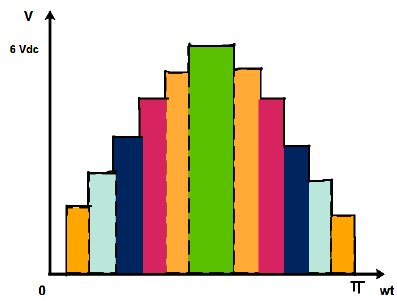
Figure 43. Model waveform for Selective Harmonic Elimination (SHE) method.